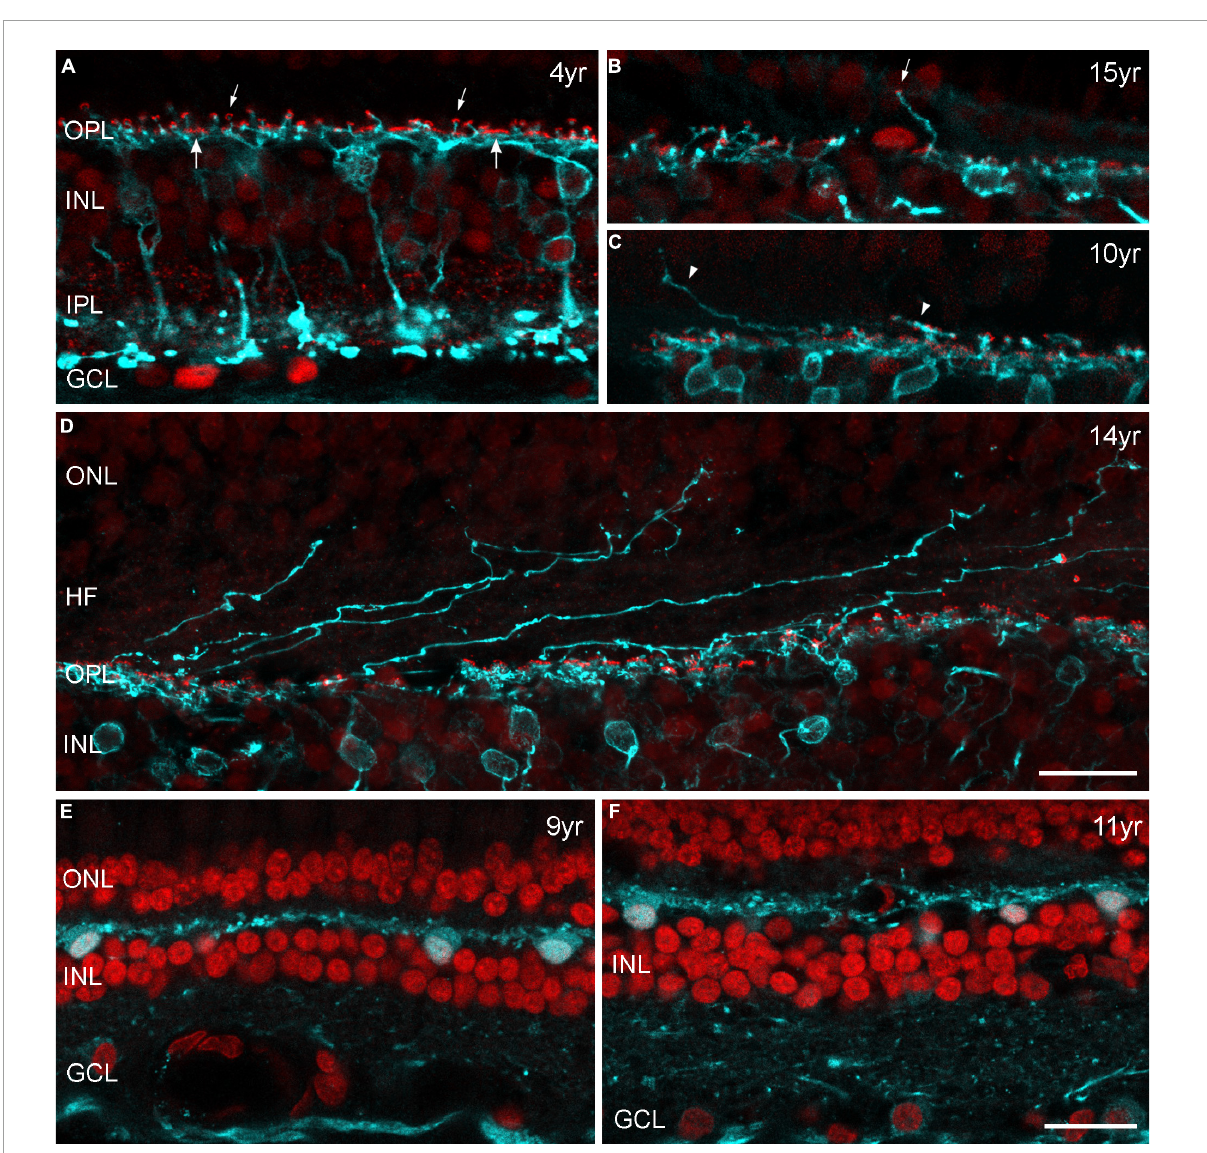
FIGURE8 (A–D) Confocal images of marmoset retina from control and aged individuals double labeled for PKC α (cyan) and CtBP2 (red). PKC α immunoreactivity is visible in rod bipolar cells with axons terminating deep within the inner plexiform layer (IPL). Antibodies against CtBP2 label all photoreceptor ribbons in the outer plexiform layer (OPL) and all bipolar cell ribbons in the IPL. In the OPL, both the horseshoe-like ribbons of rod spherules (smaller arrows) and the row of individual ribbons at the cone pedicle base (larger arrows) are apparent, and all rod spherules are innervated by PKC α -labeled dendrites. Images are from vibratome sections (A,E,F) or from radial cut edges of whole mount preparations (B–D) . (A) Peripheral retina, control marmoset (4 years old), (B) example of an outgrowing dendrite with an ectopic synapse (small arrow) in the peripheral retina of a 15-year-old female. (C) Outgrowing dendrites (arrowheads) in the central retina of a 10-year-old male. (D) Central retina of a 14-year-old female with several dendritic processes projecting into the outer nuclear layer (ONL). (E,F) Sections of peripheral retina from two old males (9 and 11 years) labeled for parvalbumin (cyan) and DAPI (red). Parvalbumin is strongly expressed in horizontal cells in the outer retina and less strongly in ganglion cells in the inner retina. Horizontal cells display normal morphology without any sprouting events. INL, inner nuclear layer; GCL, ganglion cell layer, HF, Henle fibers. Scale bar in (D,F) 20 µ m, for (A–F) ,